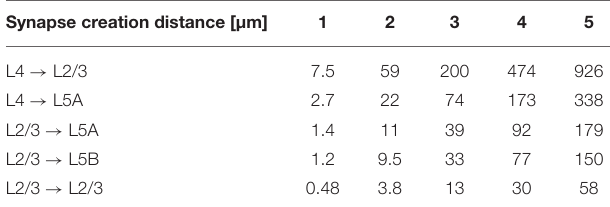
TABLE 2 | Number of synapses connecting specific cell types for various critical creation distances dist_synapse (averaged w.r.t.